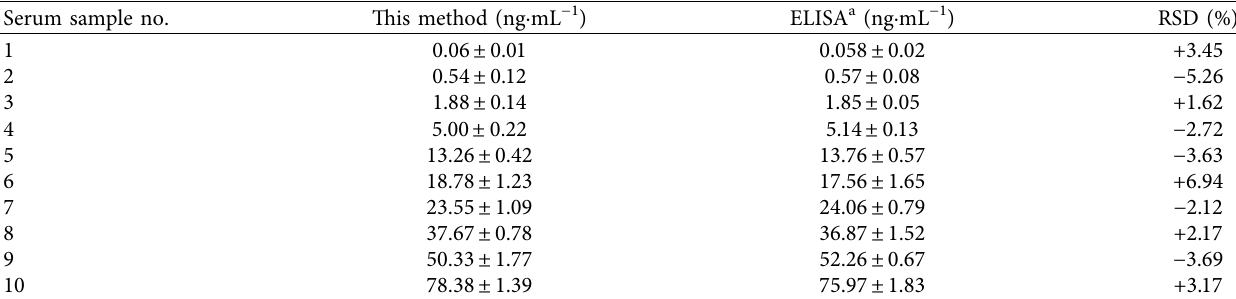
Table 2: Comparison with ELISA for CEA.